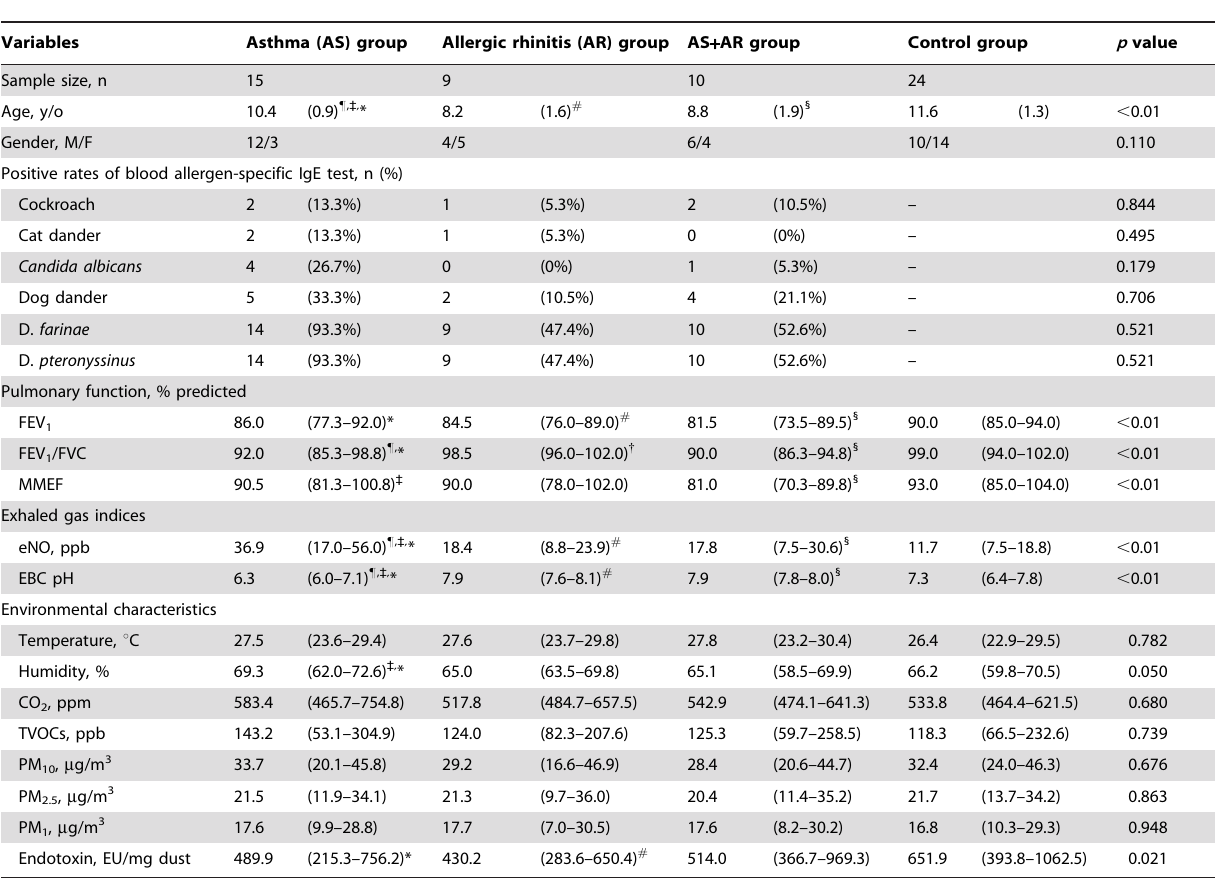
Table 1. Personal and domestic environmental characteristics of